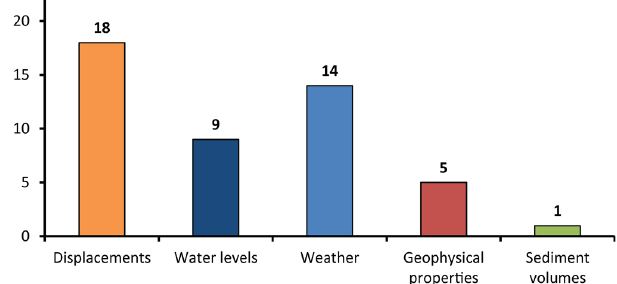
Fig. 6. Inventory of monitored parameter types for the 21 reported monitoring networks. The total number is over 21, because more than one parameter is monitored for 15 of the